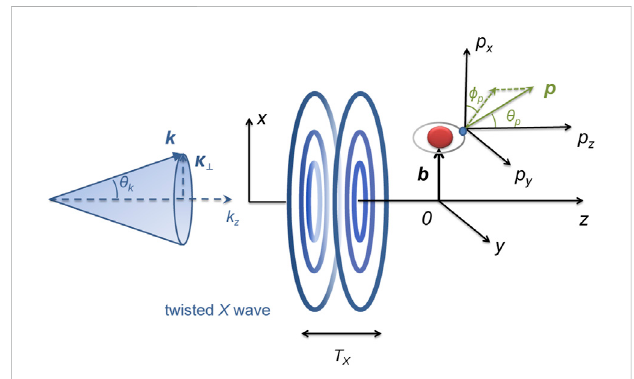
FIGURE 1 Ionization schematic of a hydrogen atom with twisted X wave with pulse duration T X . Left panel: in momentum space, all wave vectors k contributing to Eq. 3 lie on a cone with opening angle θ k = arctan( κ / k z ) with κ = | k ⊥ |. k z is parallel with z -axis. Right panel: the pulse propagates along z direction. An atom is localized at the impact parameter b =( b , ϕ b = 0, z b = 0) relative to the beam z -axis. Then, x - z plane is determined by the position of the target and the pulse propagation. The photoelectron is observed with asymptotic momentum p =( p , ϕ p , θ p ) at the